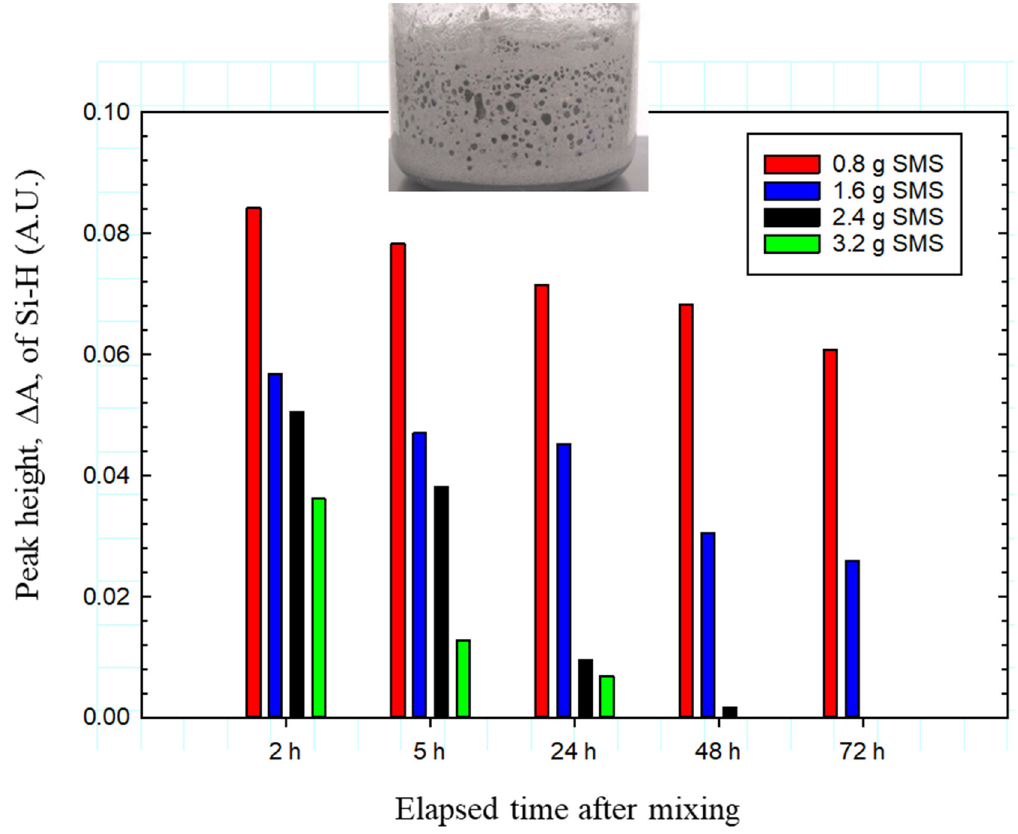
Figure 3. Changes in peak height, ∆ A, of Si–H band as a function of elapsed time from the start of the reaction for PMHS/FCS blends in the presence of SMS.